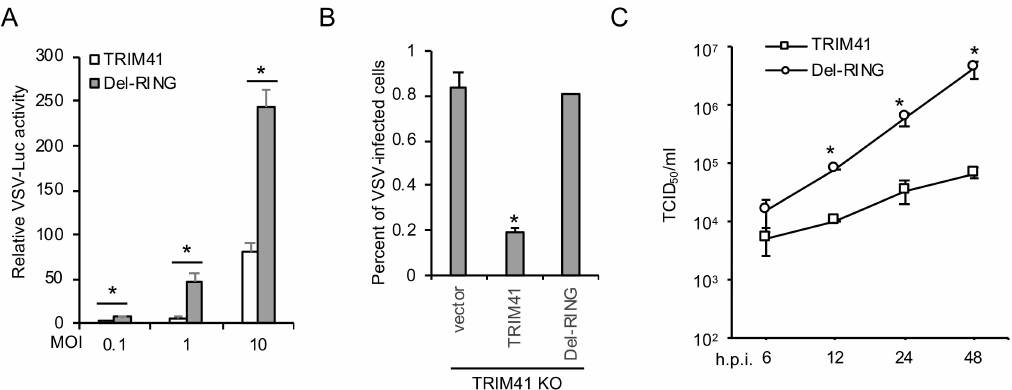
Figure 4. E3 ligase activity is required for TRIM41 anti-VSV function. ( A ) HEK293 cells were transfected with FLAG-tagged TRIM41 or the RING deletion mutant (Del-RING). After 24 h, cells were infected with designated MOIs of VSV for 12 h. Relative VSV activities were determined by the luciferase activities that were normalized to the control. Data represent means ± s.d. of three independent experiments. The P value was calculated by two-tailed Student’s t -test. An asterisk indicates p < 0.05. ( B ) TRIM41 knockout HEK293 cells were transfected with pCMV-3Tag-8 vector, TRIM41-FLAG, or the Del-RING for 24 h, then infected with 0.1 MOI of VSV-GFP for 12 h. The percentage of GFP-positive cells was adopted to determine infection activity. An asterisk indicates p < 0.05. ( C ) TRIM41 HEK293 knockout cells were transfected with wild type TRIM41 or the Del-RING mutant for 24 h, followed